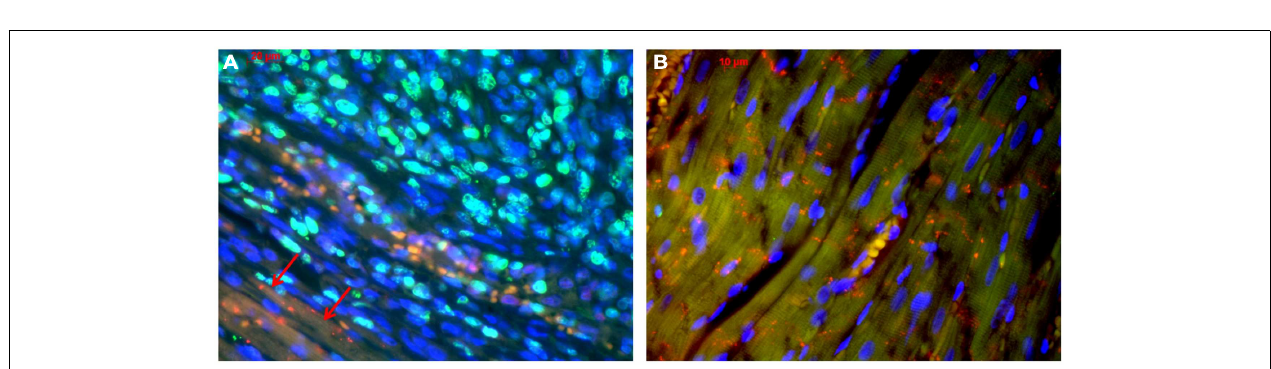
FIGURE 5 |Tumor-heart border [(A); red arrows mark the transition to the heart] and non-infiltrated normal heart tissue (B). Co-staining of Ki-67 (green), Cx43 (red), and nuclei (blue).